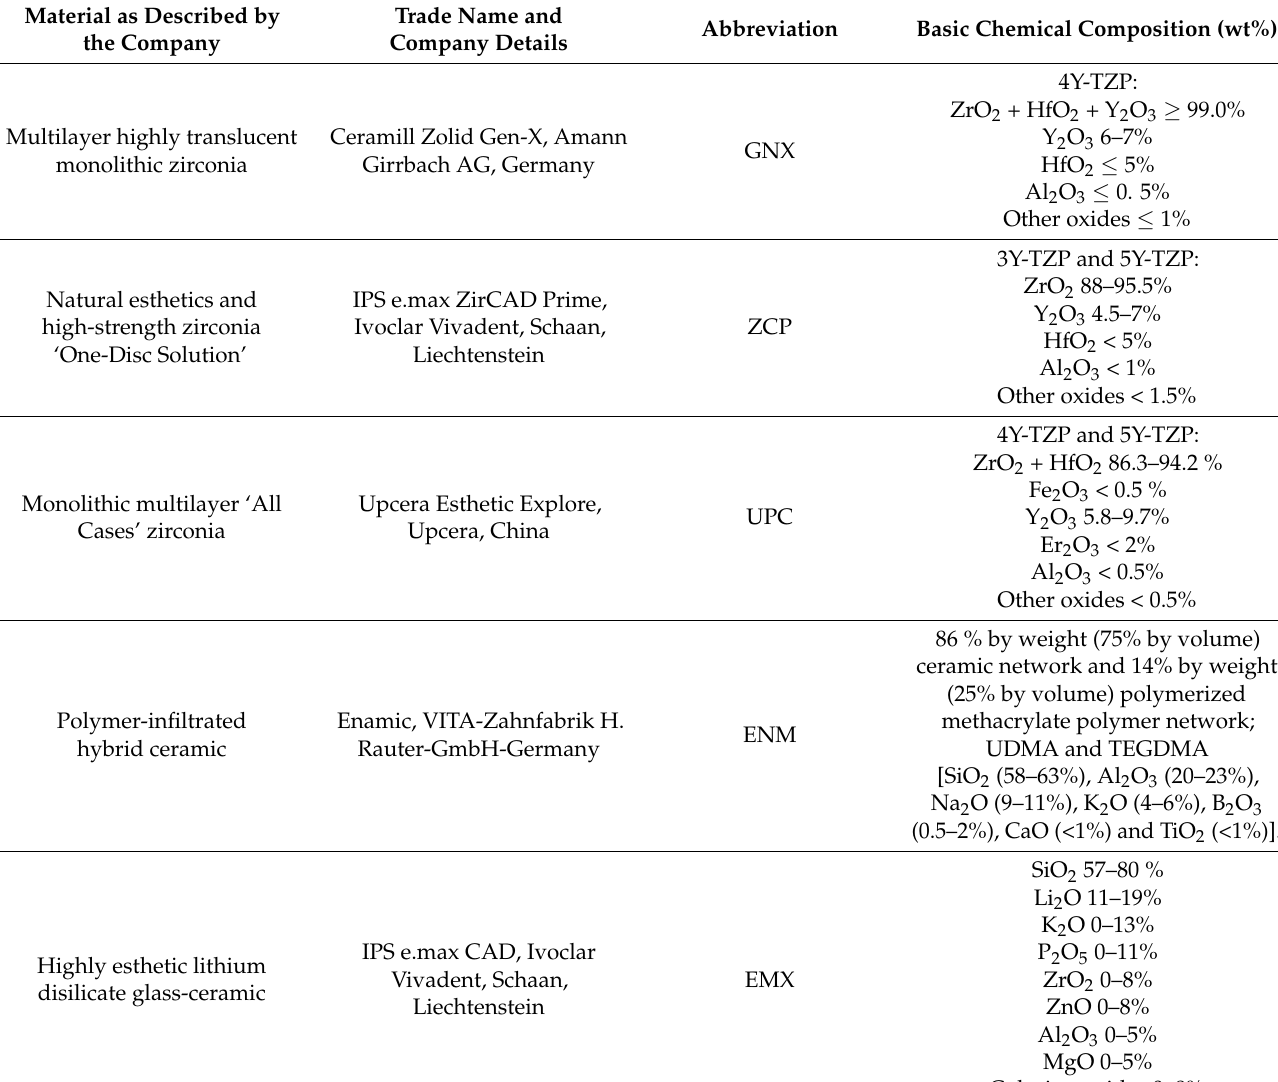
Table 1. Ceramic materials used in this